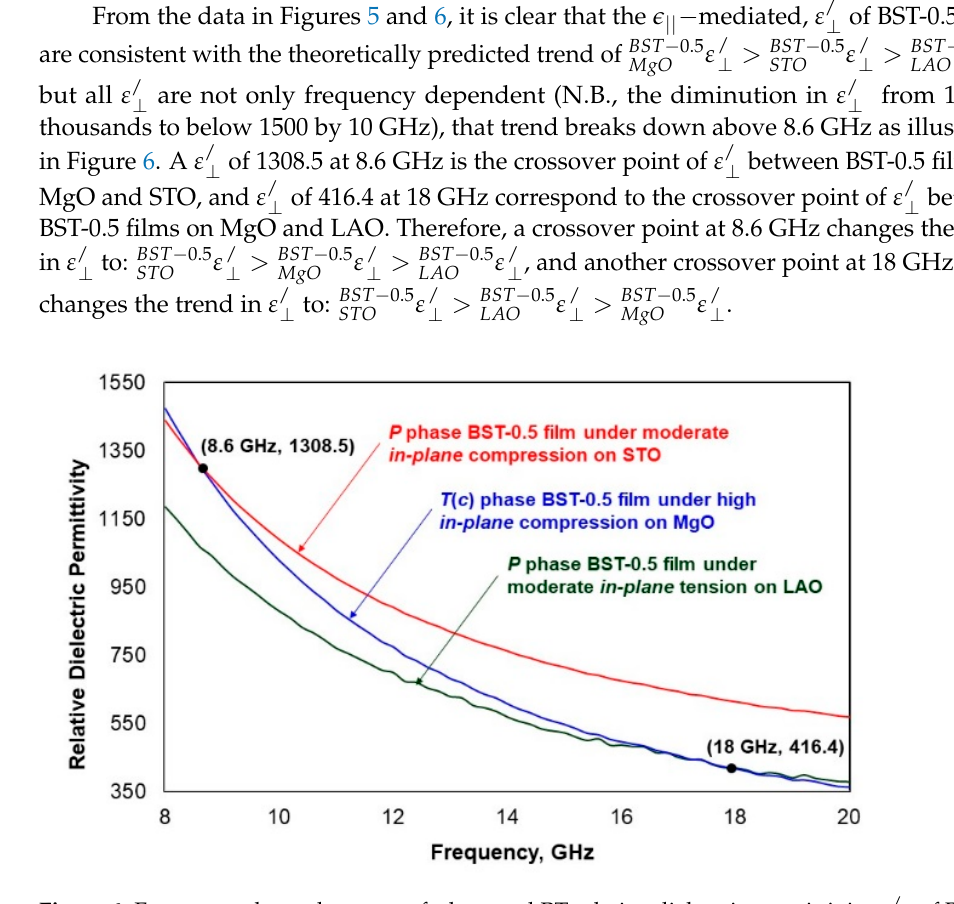
Figure 6. Frequency-dependent, out-of-plane and RT relative dielectric permittivity, ε / films on single crystal substrates at 8–20 GHz with zero dc bias.